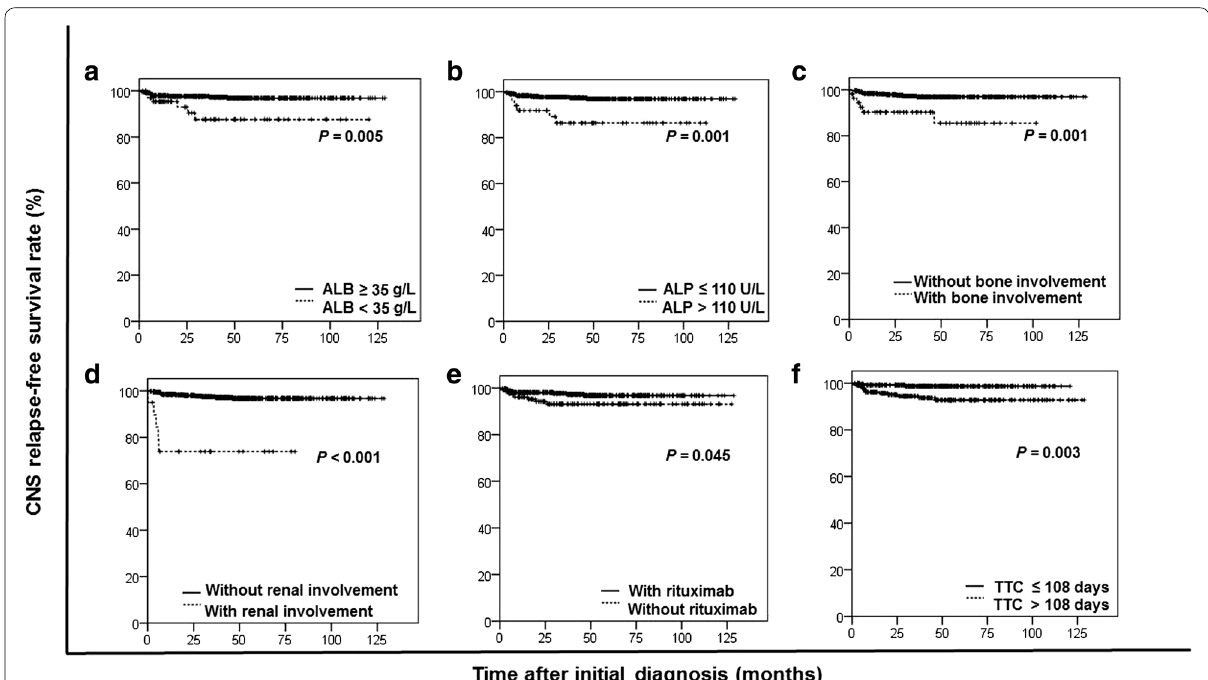
Fig. 2 Kaplan–Meier analysis estimated central nervous system (CNS) relapse‑free survival for the 511 diffuse large B‑cell lymphoma (DLBCL) patients stratified by independent risk factors. A low albumin (ALB) level at diagnosis ( a ), a high alkaline phosphatase (ALP) level ( b ), bone involve‑